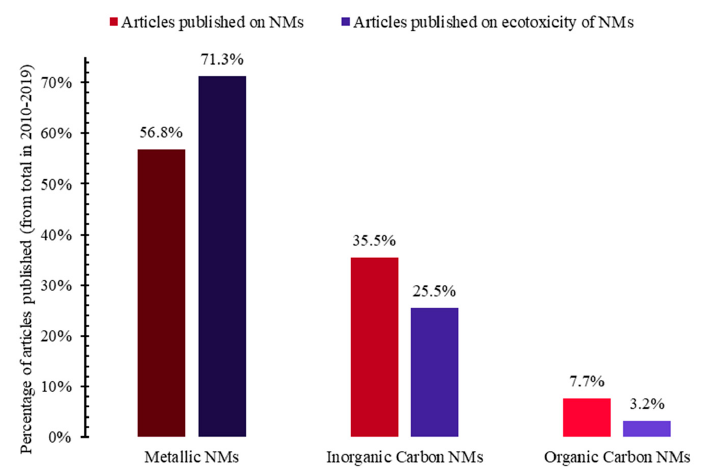
Figure 17. Bibliometric analysis of research on nanomaterials and their ecotoxicity by nanomaterial category in 2010–2019 from Web of Science Core Collection (Web of Science, Clarivate Analytics), the search strategy used to retrieve the data being: TS=(Nano* AND polyhydroxyalk*) AND TS=(Ecotox*), TS=(Nano* AND polylact*) AND TS=(Ecotox*), TS=(Nano* AND algin*) AND TS=(Ecotox*), TS=(Nano* AND aluminum*) AND TS=(Ecotox*), TS=(Nano* AND platinum*) AND TS=(Ecotox*), TS=(Nano* AND Chitosan*) AND TS=(Ecotox*), TS=(Nano* AND cobalt*) AND TS=(Ecotox*), TS=(Nano* AND cellulos*) AND TS=(Ecotox*), TS=(Nano* AND cerium*) AND TS=(Ecotox*), TS=(Nano* AND cadmium*) AND TS=(Ecotox*), TS=(Nano* AND graphen*) AND TS=(Ecotox*), TS=(Nano* AND fuller*) AND TS=(Ecotox*), TS=(Nano* AND silver*) AND TS=(Ecotox*), TS=(Nano* AND iron*) AND TS=(Ecotox*), TS=(Nano* AND gold*) AND TS=(Ecotox*), TS=(Nano* AND copper*) AND TS=(Ecotox*), TS=(Nano* AND zinc*) AND TS=(Ecotox*), TS=(Nanotub* AND carbon*) AND